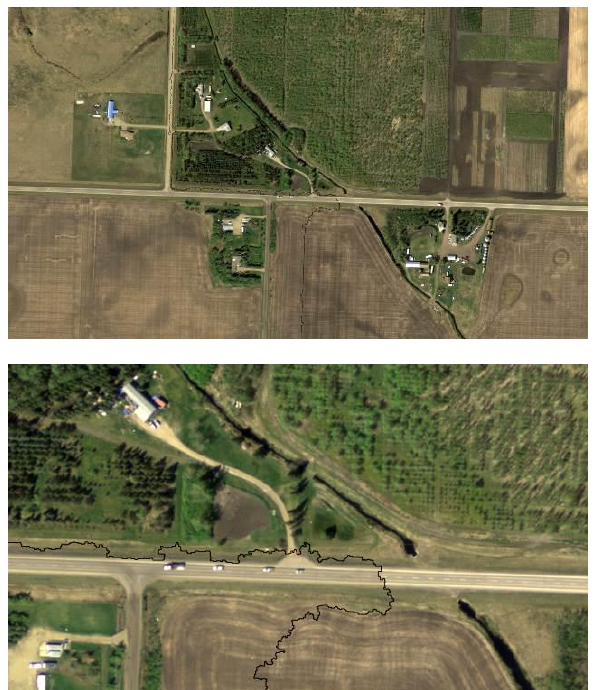
Figure 14. An example of a seamline following running across a road